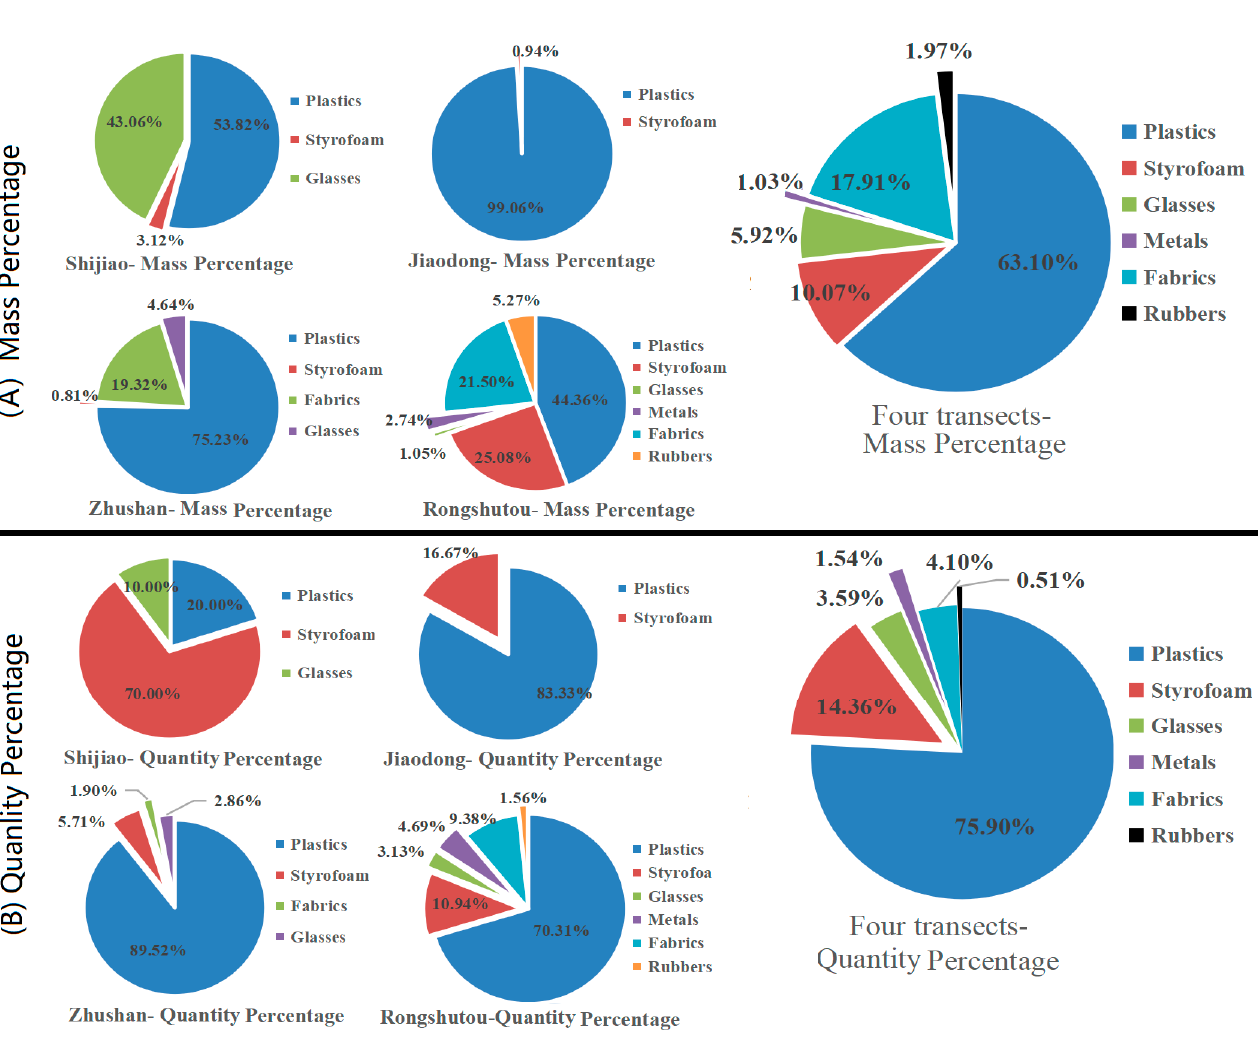
Figure 3. The mass ( A ) and quantity ( B ) densities of the debris.